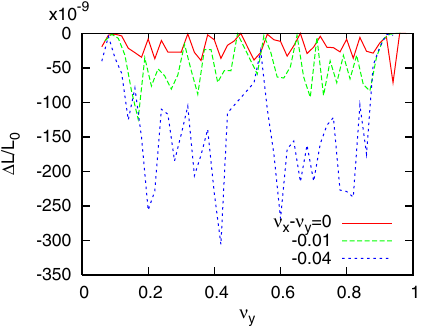
FIG. 11. Luminosity decrement as a function of tune for θ = 2 ¼ 143 μ rad. The three curves correspond to ν c − 0 . 01 , and − 0 . 04 . The total beam-beam tune shift is ξ